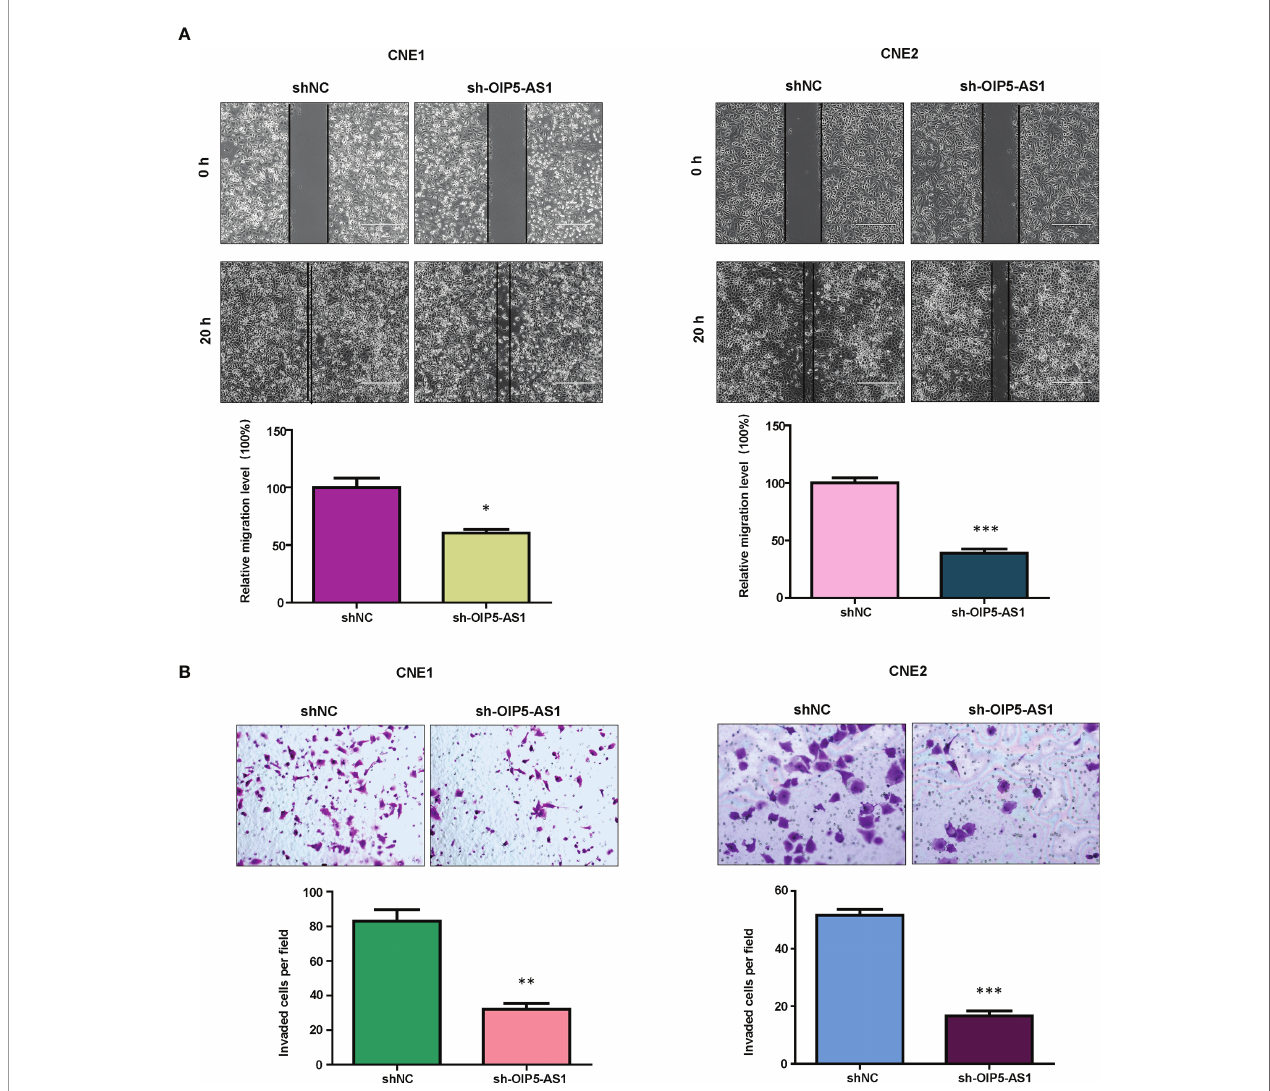
FIGURE 2 | Knockdown of OIP5-AS1 inhibits migration and invasion of NPC cells. (A), Wound healing assays were utilized to measure the migratory activity of NPC cells after OIP5-AS1 knockdown (Top panel). Quantitative data are represented (Bottom panel). * P<0.05 vs control; ***P<0.001 vs control. (B), Transwell matrigel invasion analysis was utilized to test the invasiveness capacity of NPC cells after OIP5-AS1 knockdown (Top panel). Quantitative data are represented (Bottom panel) ** P<0.01 vs control; ***P<0.001 vs